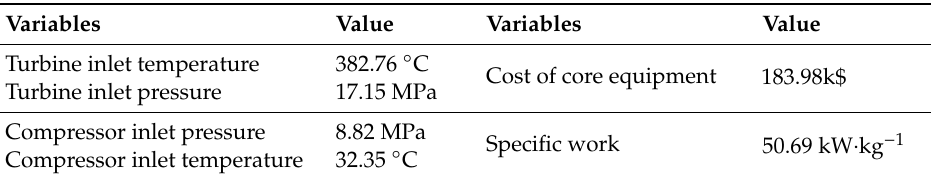
Table 6. System parameters in typical optimization results.